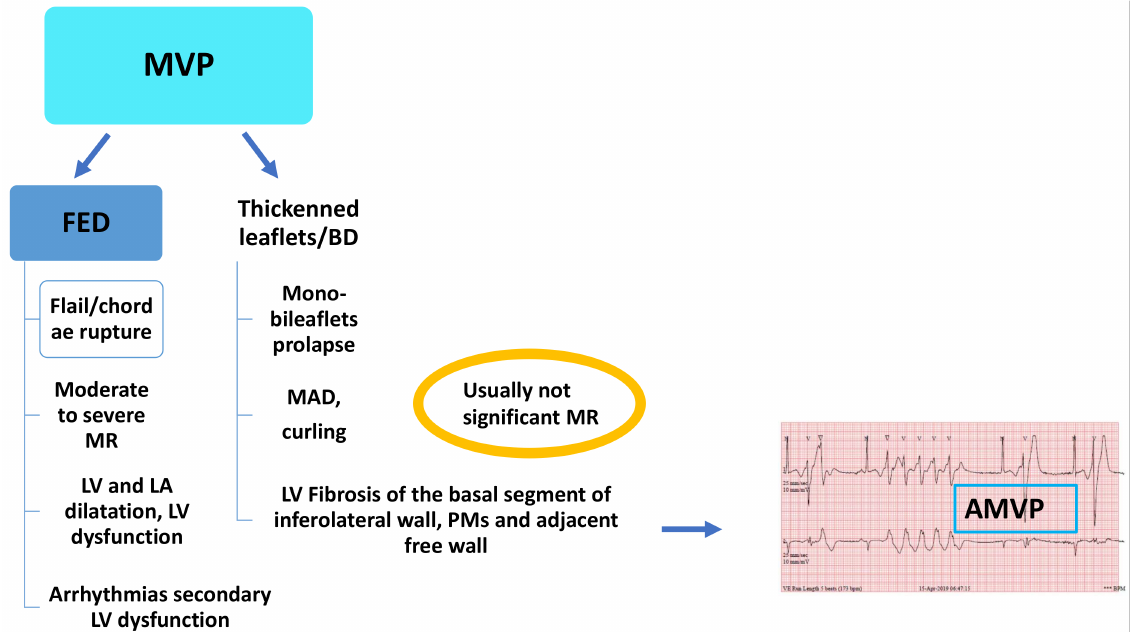
Figure 2. Mitral valve prolapse (MVP): fibroelastic deficiency (FED), Barlow’s disease (BD). AMVP, arrhythmic mitral valve prolapse; LA, left atrium; LV, left ventricle; MAD, mitral annulus disjunction; MR, mitral regurgitation; PM, papillary